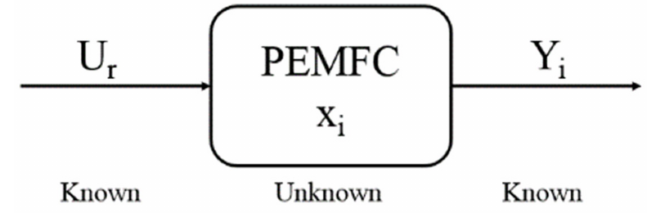
Figure 2. Known and unknown variables